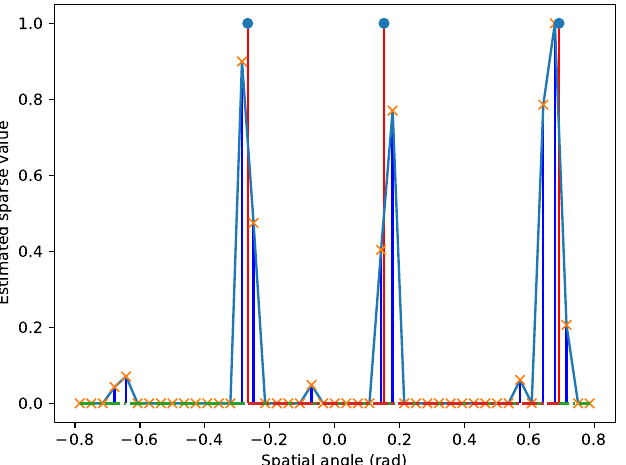
Figure 13. The reconstructed sparse signal using AtomicNet and 2-bit ADC, where the red line denotes the ground-truth DOA and the blue line denotes the estimated spatial